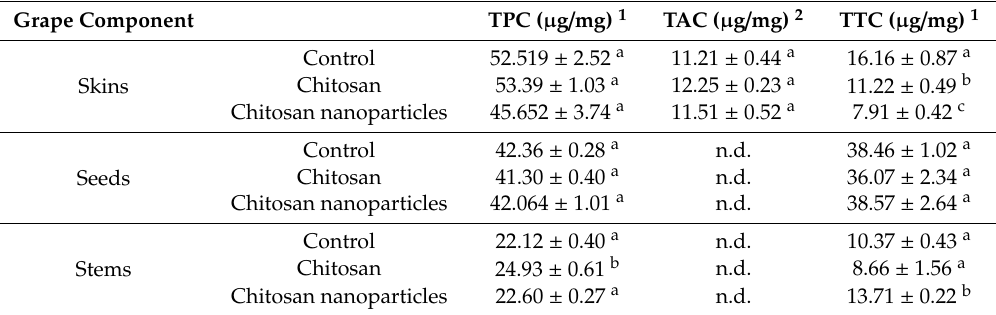
Table 1. Total phenolic content (TPC), total anthocyanin content (TAC) and total tannin content (TTC) of the skins, seeds and stems of Sous ã o variety with no treatment (control), treated with chitosan and with chitosan nanoparticles (mean ± SD, n =